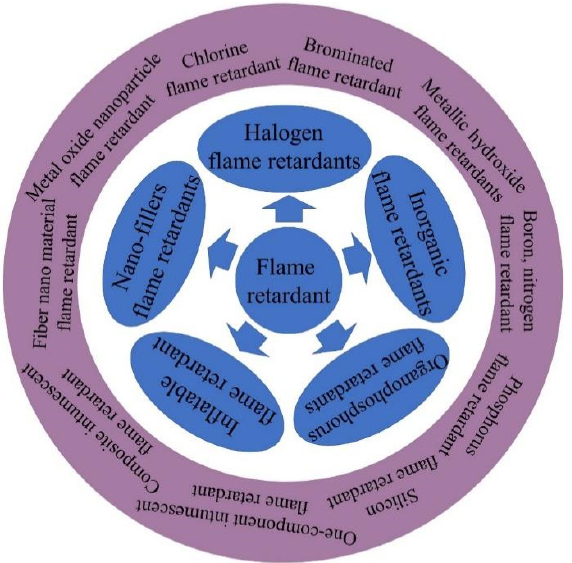
Figure 1. Classification of flame-retardant polymer materials.